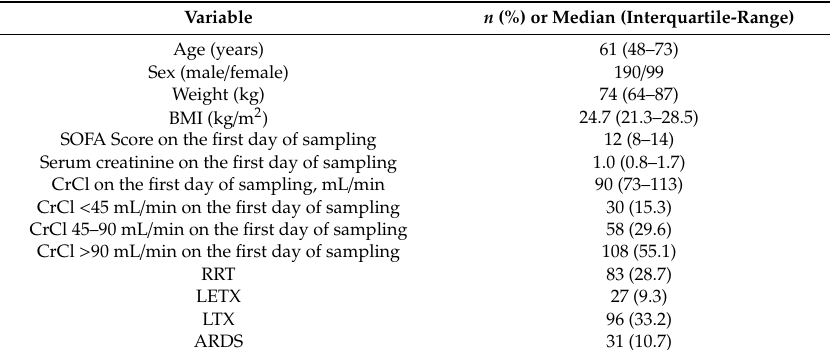
Table 1. Demographic and clinical